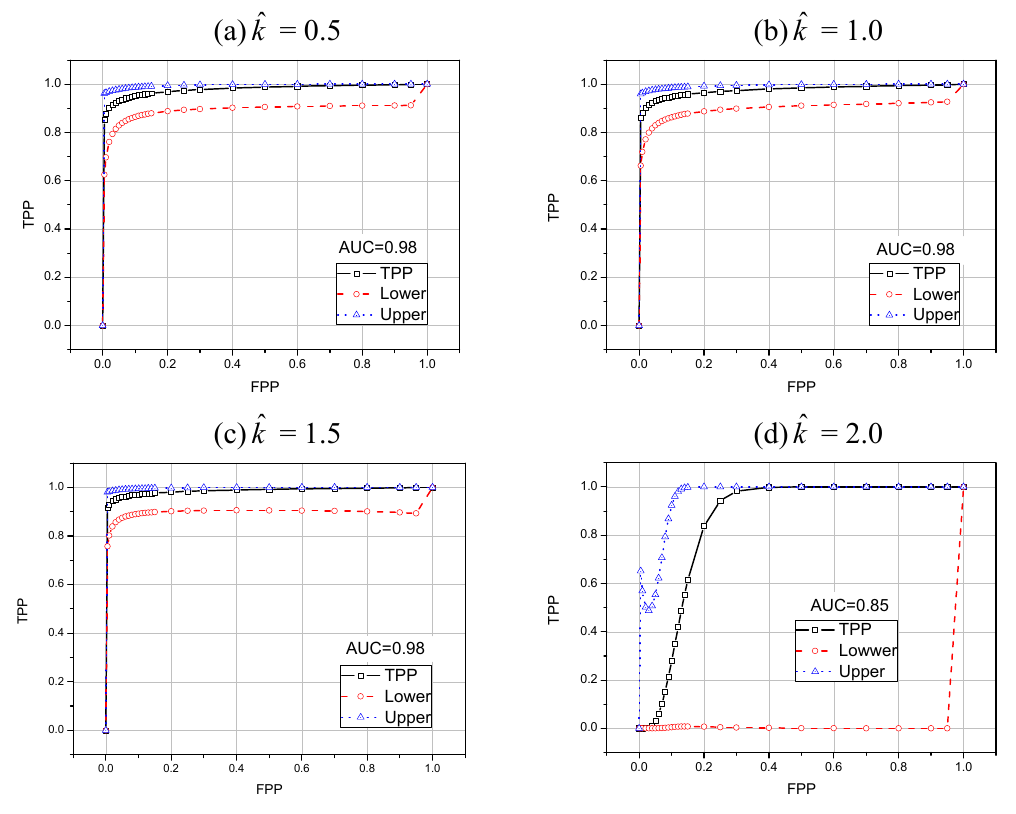
Figure 12. ROC curves when attacking traffic rate is 10 times faster than normal traffic